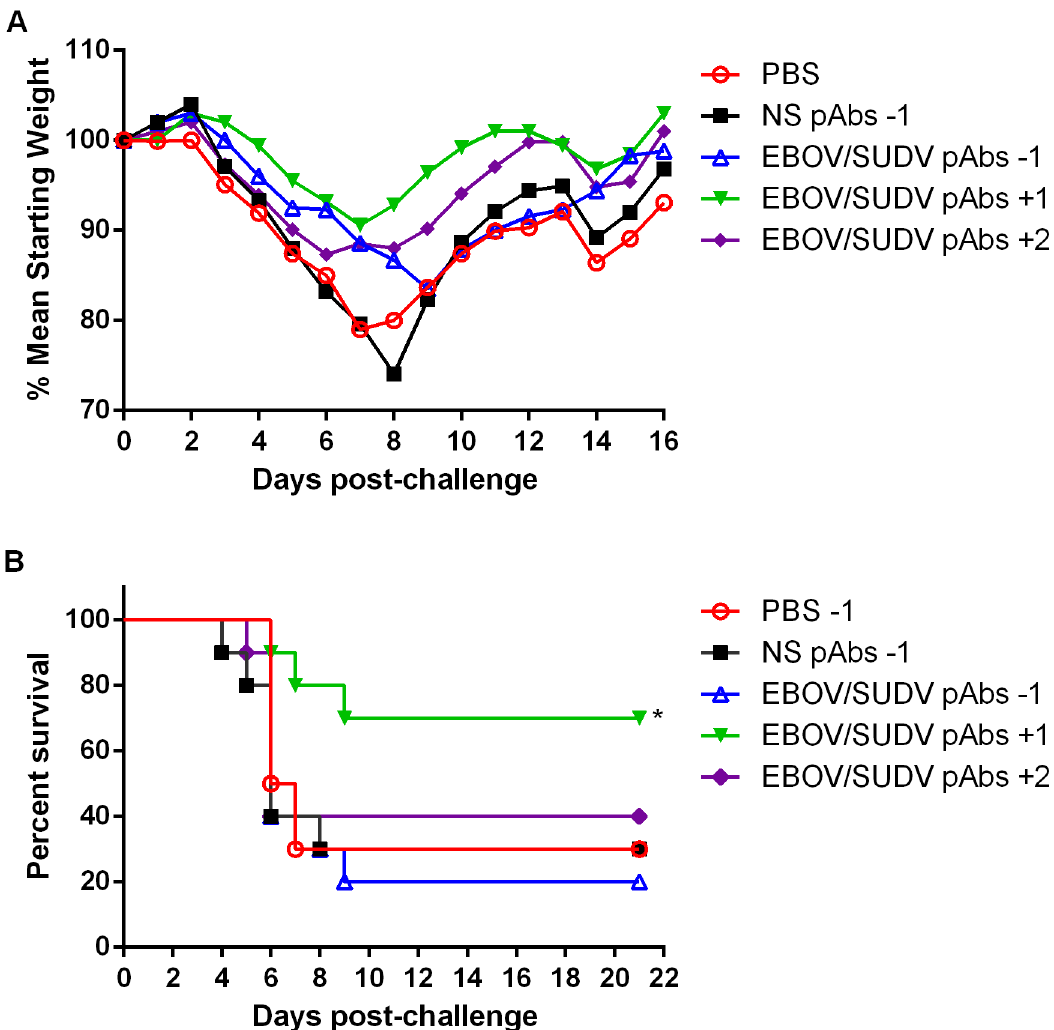
Fig 4. Weight loss and survival of BALB/c mice challenged with maEBOV when administered purified EBOV/SUDV human pAbs before or after challenge. Groups of BALB/c mice (N = 10) received a single IP injection of PBS, 100mg/kg NS pAbs, or 100mg/kg EBOV/SUDV pAbs one day before, or one or two days after challenge with 1000 pfu of maEBOV by IP injection. (A) Mean weight was determined daily for each dosing group and graphed as the percent mean of the starting weight. (B) Kaplan-Meier survival curves indicating the percentage of surviving mice at each day of the 21-day post-challenge observation period are shown. Survival of mice receiving the NS pAbs compared to the EBOV/SUDV pAbs one day before challenge ( p = 0.9573), NS pAbs vs EBOV/SUDV pAbs one day after challenge ( p = 0.0449), and NS pAbs vs EBOV/SUDV pAbs two days after challenge ( p = 0.5720). Significant differences between survival curves are denoted by ( * ) where p <